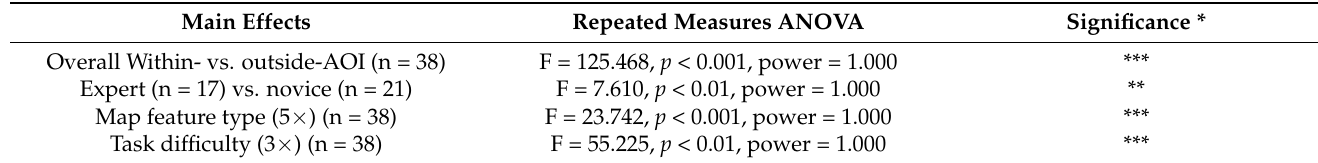
Table 2. Main effects of independent variables and within- vs. outside AOI analysis.